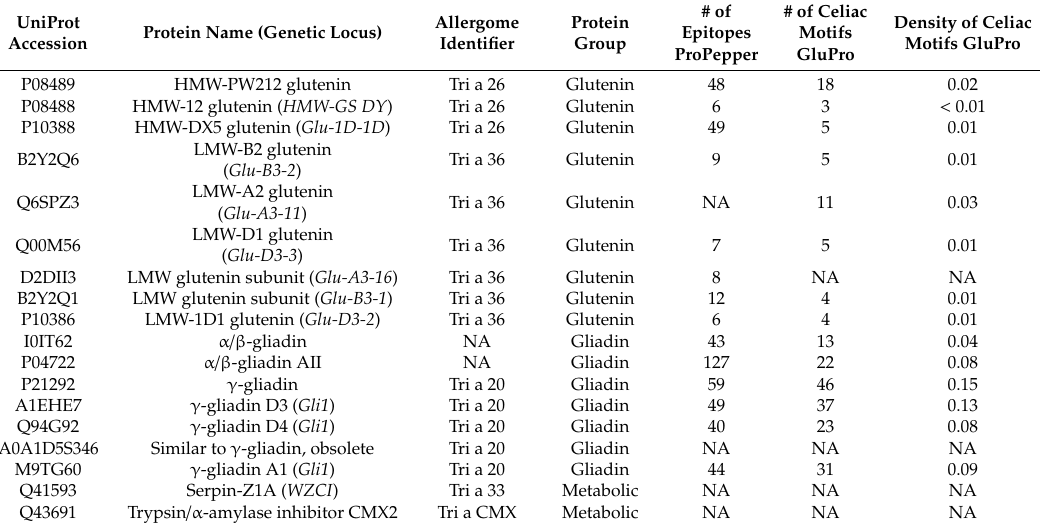
Figure 4. Cumulative coefficient of contrastingly accumulated proteins with harmful epitopes discovered with both experimental approaches among bread wheat genotypes; from a total of 61 identified polypeptides, 29 are of medical concern. Modern cultivar Sotnytsia scored lowest, while landrace Ukrainka accumulated the most allergenic / toxic proteins in grain. Table 3. Detailed characteristics of discovered allergenic or toxic proteins di ff erentially accumulated among bread wheat cultivars. Information about reactive motifs was extracted from dedicated databases—Allergome, ProPepper, and GluPro, NA—not